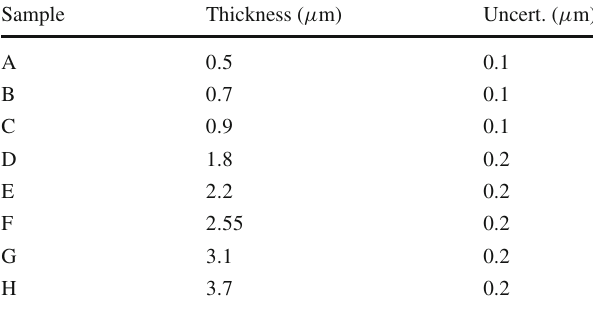
Table 1 Summary of samples fabricated and studied in this work. The thickness column referes to the TPB film thickness as measured by a